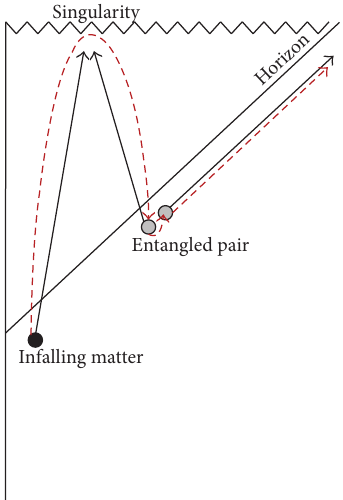
Figure 3: Schematic description of the final-state solution, with the red dotted line showing the path taken by the information contained in the infallen matter as it is teleported back in